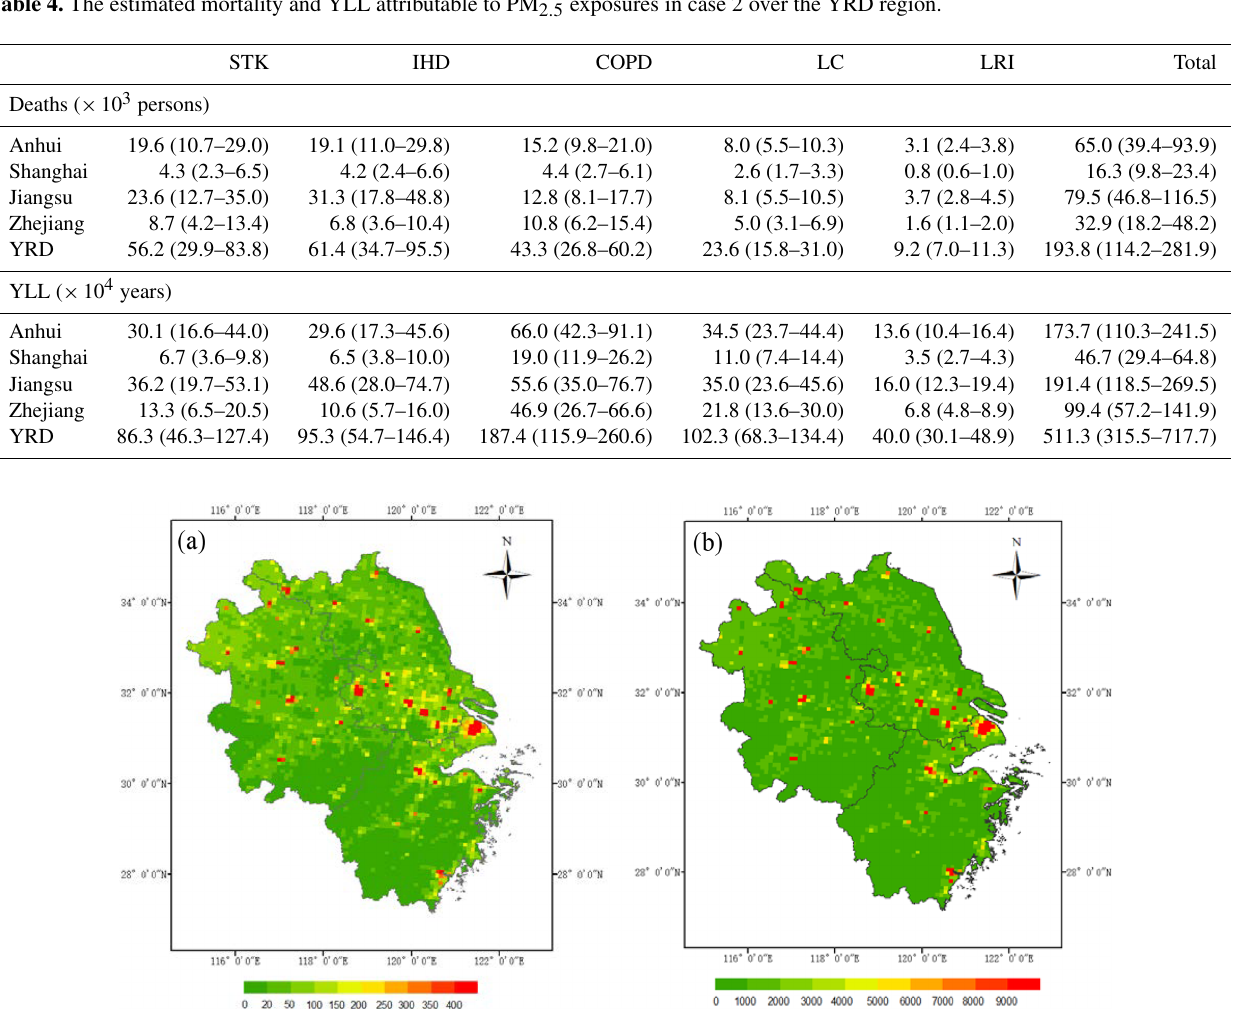
Figure 7. The spatial distributions of the mortality (a) and YLL (b) attributable to PM 2 . 5 exposure in case 2 at a horizontal resolution of